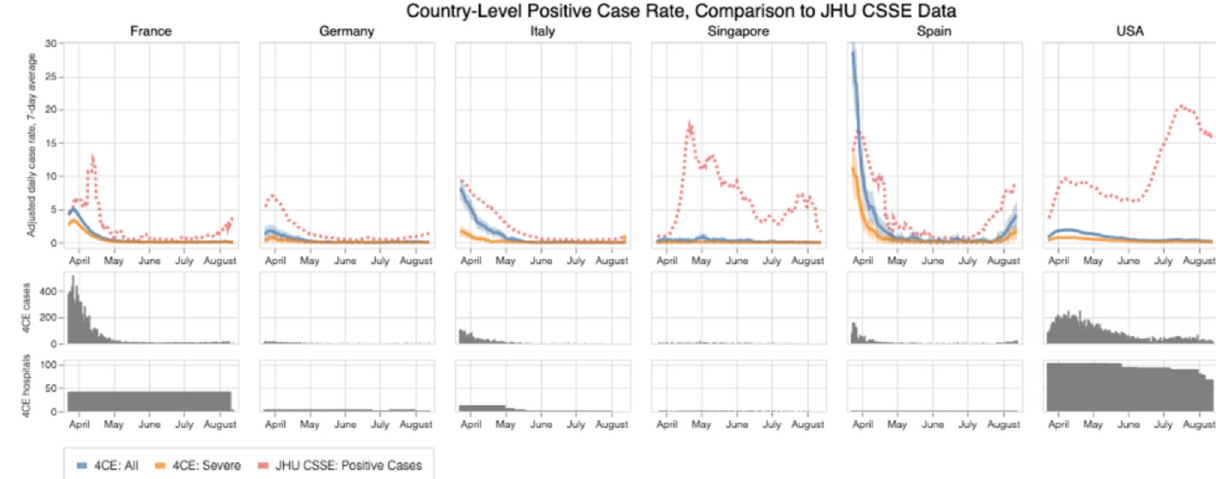
Fig. 1 Comparison of National Hospitalization Rates by Data Source. Adjusted 7-day average new hospitalization rate and rate of ever- severe disease per 100,000 people by country based on 4CE contributors along with 95% con fi dence intervals compared with 7-day average new case rates collected by Johns Hopkins Center for Systems Science and Engineering (JHU